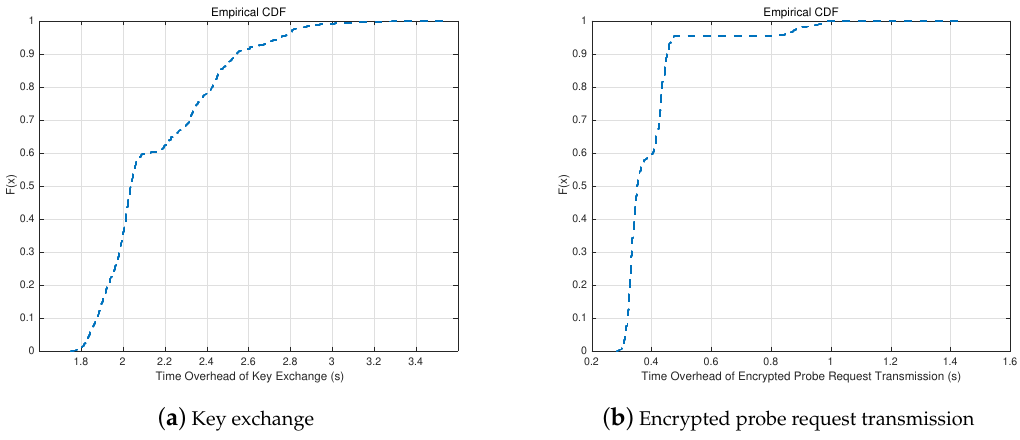
Figure 9. Time overhead of the two phases in the defense